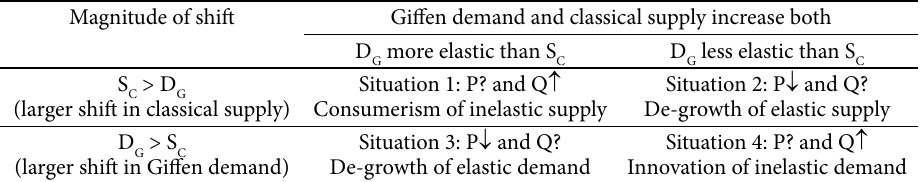
Table 4.2. Simultaneous shifts (Decreases) of Giffen demand and classical supply in the same direction Magnitude of shift Giffen demand and classical supply decrease both more elastic than S D G Situation 5: P? and Q ↓ S > D C G Speculation of supply (if P ↑ ) (larger shift in classical supply) De-growth of inelastic supply D > S Situation 7: P ↑ and Q? G C (larger shift in Giffen demand)